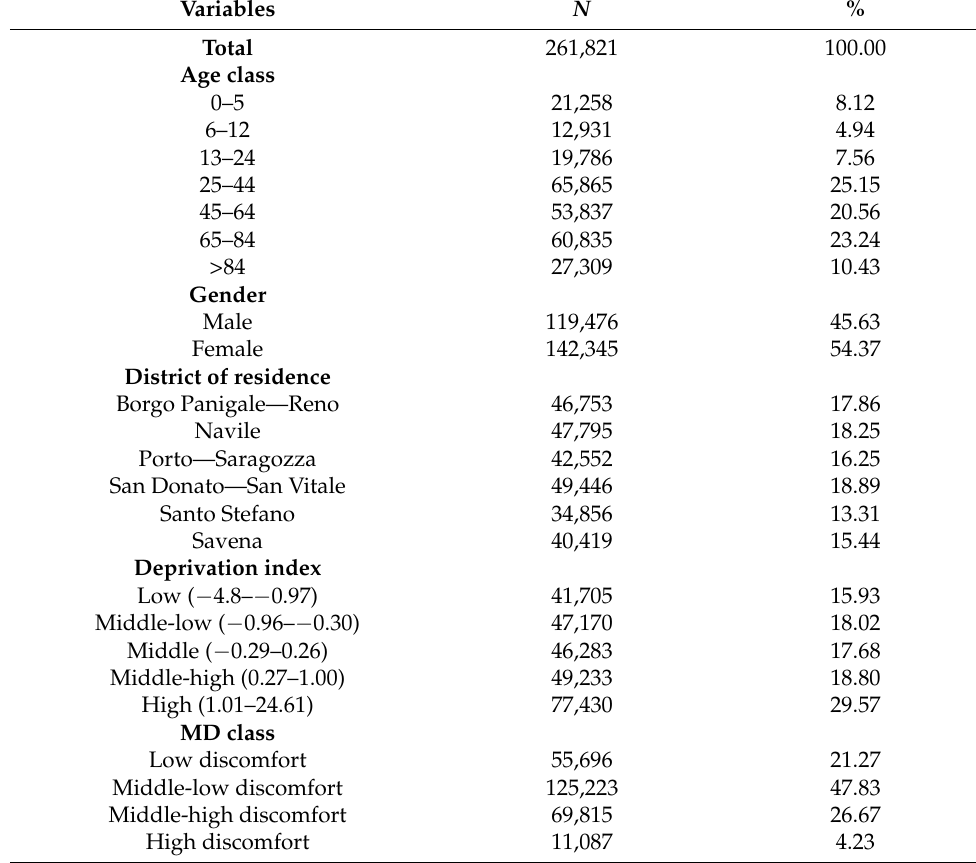
Table 2. Descriptive statistics of the EDV attendees, Bologna